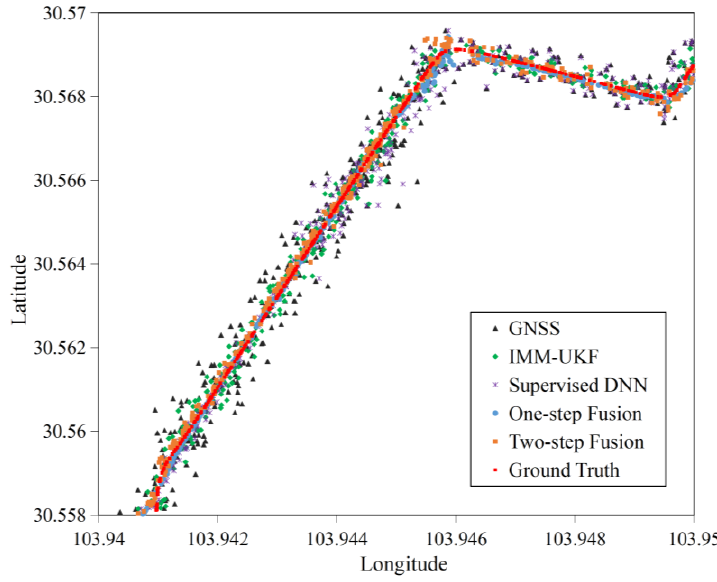
Figure 9. Location distributions in Scenario 1.